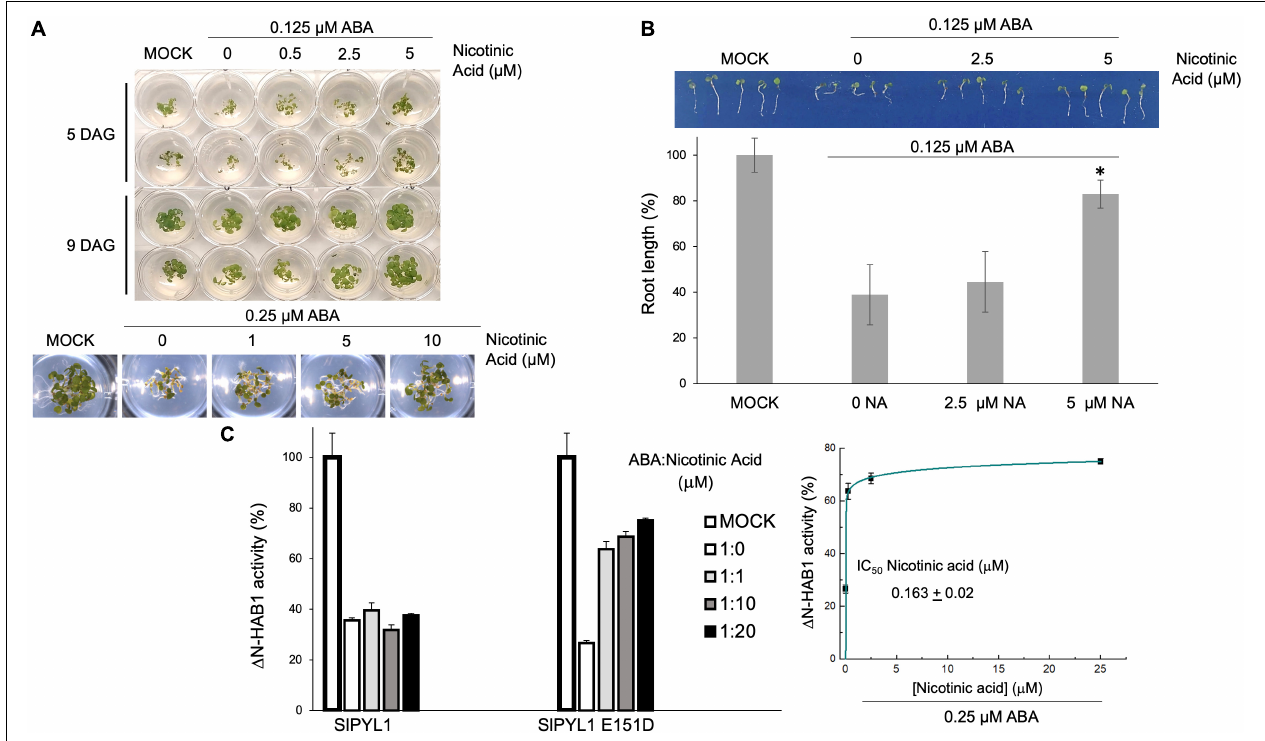
FIGURE 5 | ABA-mediated inhibition of seedling establishment is counteracted by increasing concentrations of nicotinic acid. (A) Approximately 25 seeds (two replicates per experiment) of Arabidopsis thaliana Col-0 seeds were sown on 24-multiwell plates lacking (MOCK control) or supplemented with 0.125 µ M ABA. Increasing concentrations (0.5, 2.5, and 5 µ M) of nicotinic acid were added in those wells supplemented with 0.125 µ M ABA. Seedling establishment and early seedling growth was scored at 5 and 9 days after sowing. (B) Root length was scored at 5 days after sowing. ∗ p < 0.05. (C) ABA-antagonist activity of nicotinic acid. Increasing concentrations (0.25, 2.5, and 5 µ M) of nicotinic acid were added to the reaction mixture supplemented with 0.25 µ M